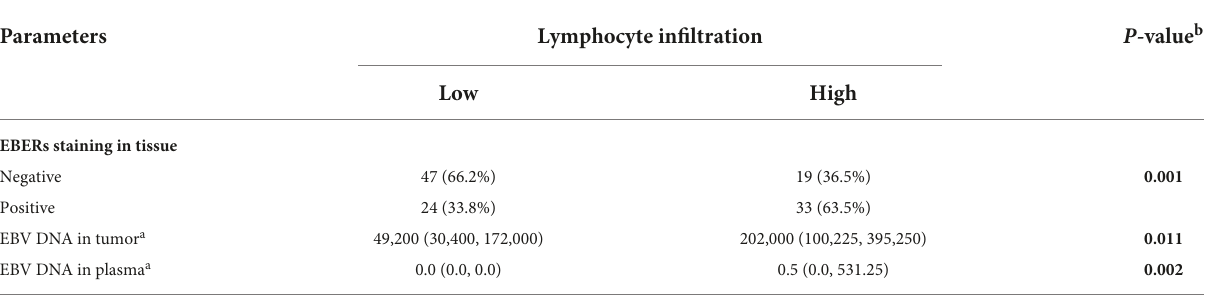
TABLE 5 Association between Epstein–Barr virus (EBV) status and lymphoid infiltration in primary tumor of gastric cancer.